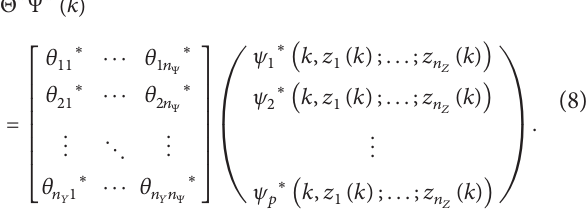
Figure 1: The MIMO Wiener